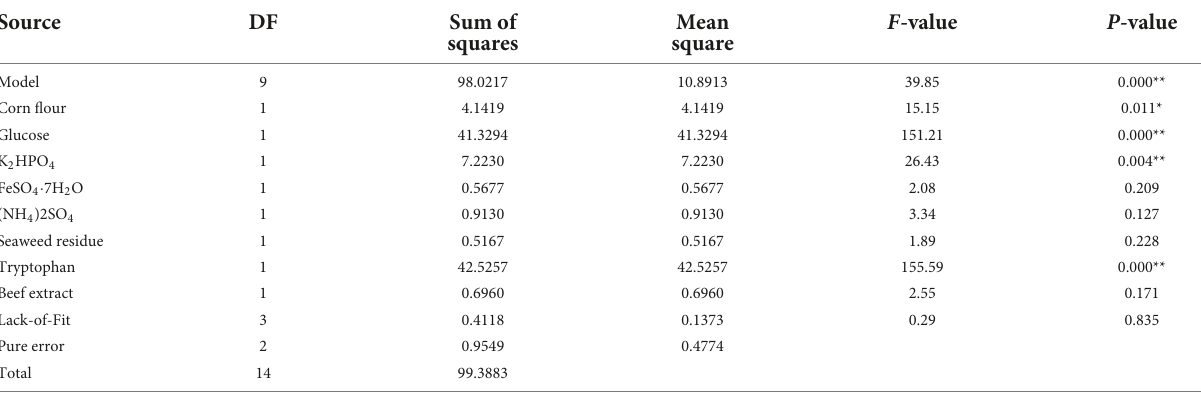
TABLE 5 Analysis of variance (ANOVA) for 8-run Plackett–Burman design and model fitting. Source DF Sum of